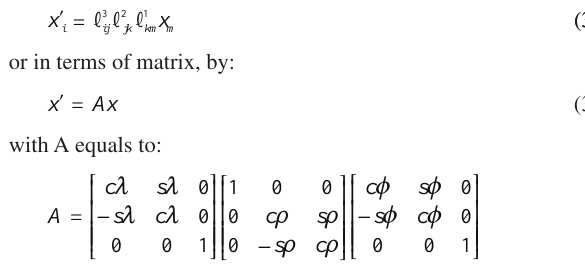
Figure 5. Material Axes and Board Axes for wood.